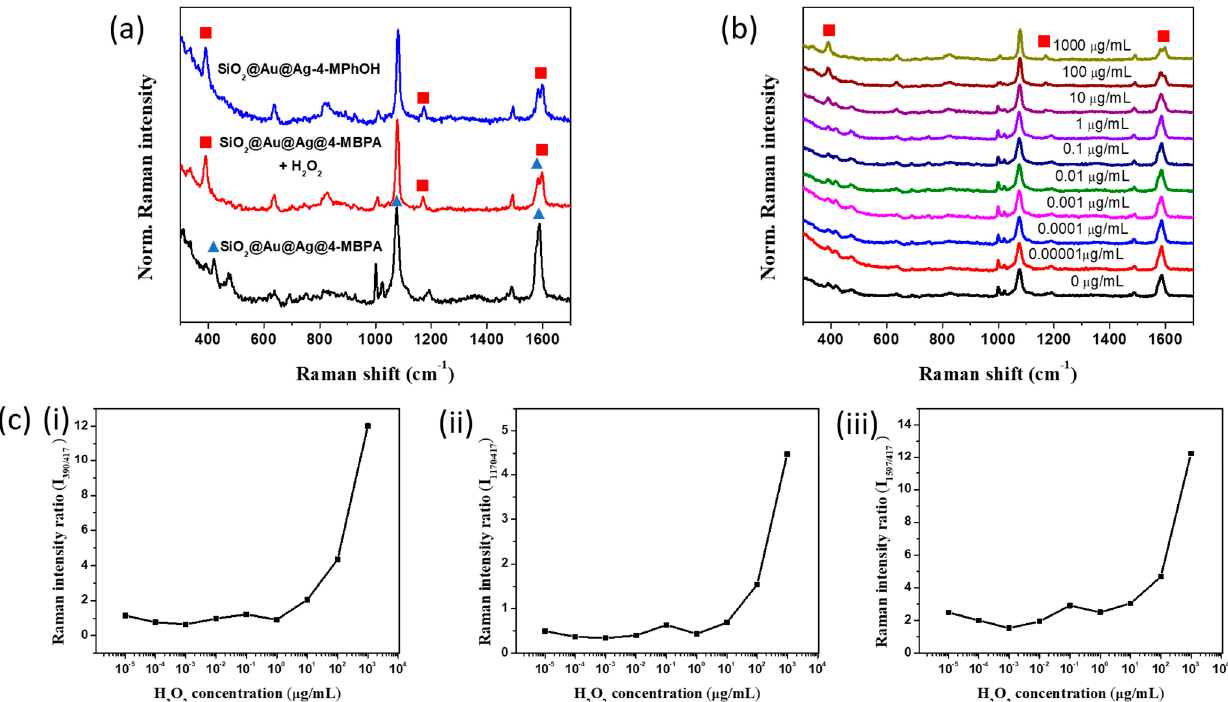
Figure 3. ( a ) SERS spectra and ( b ) SERS intensity of SiO 2 @Au@Ag@4-MPBA, and ( c ) SERS intensity ratio of I 390/417 , I 1170/1077 , I 1597/1583 toward various concentration of H 2 O 2 from 10 pg/mL to 1 mg/mL in PBST pH 7.0.